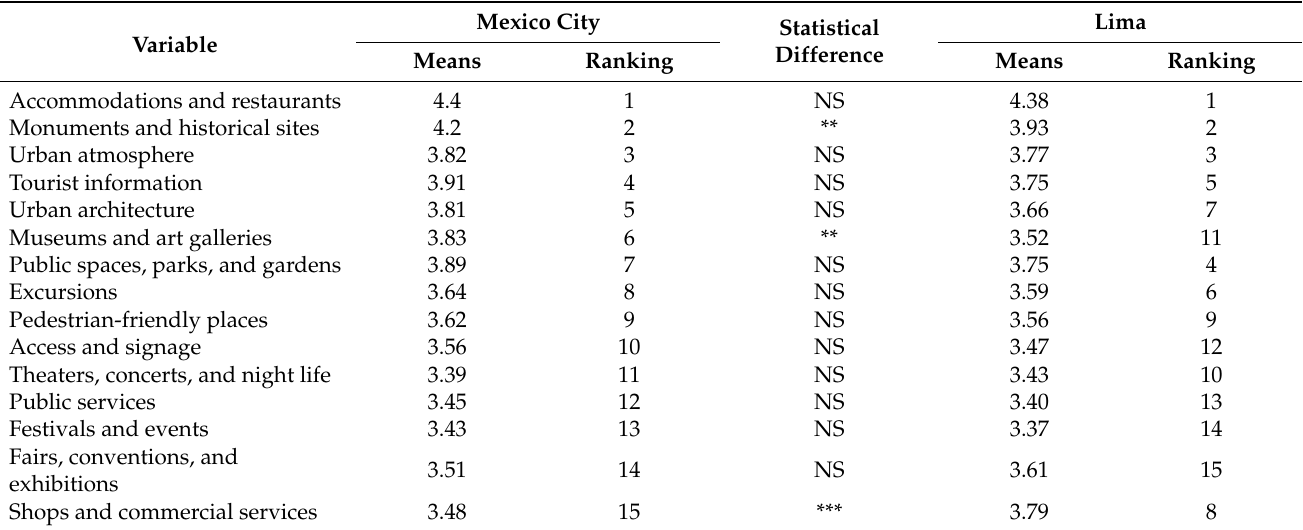
Table 4. Means and ranking of importance of tourism attractiveness